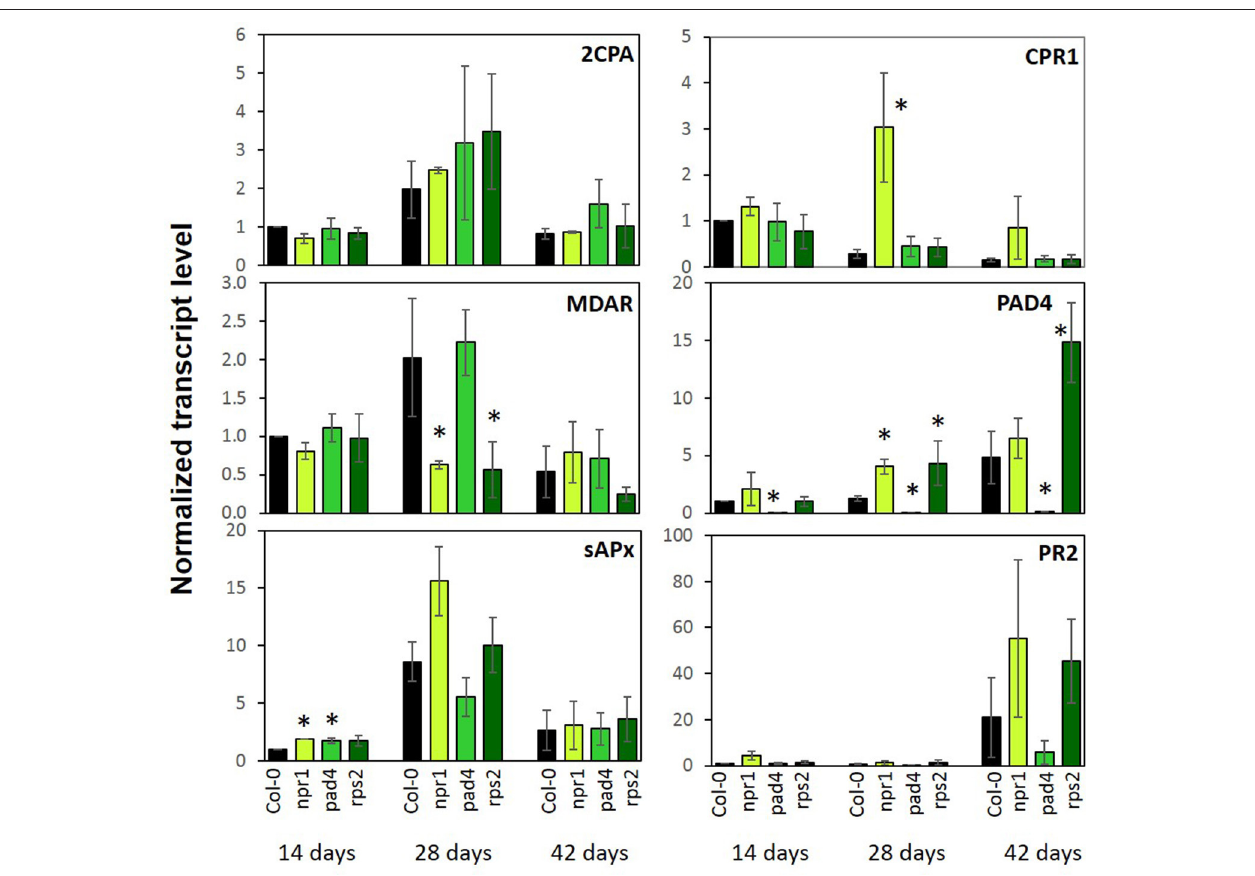
FIGURE 10 | Transcript levels of genes encoding chloroplast antioxidant enzymes and marker genes for the pathogen defense response in 2-, 4-, and 6-week old npr1 , pad4 , rps2 , and wildtype (Col-0). Bars represent the mean and standard error of three biological experiments, each measured in triplicate by qRT-PCR and normalized to At3g18780 (F-box) and At5g15710 (YLS8). Statistically significant differences between developmental time points for a single genotype are indicated with an asterisk (ANOVA, P < 0.1).